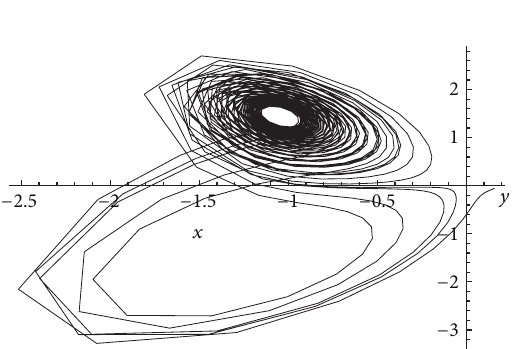
Figure 3: Phase portrait x - y 𝛼 = 0.96 .